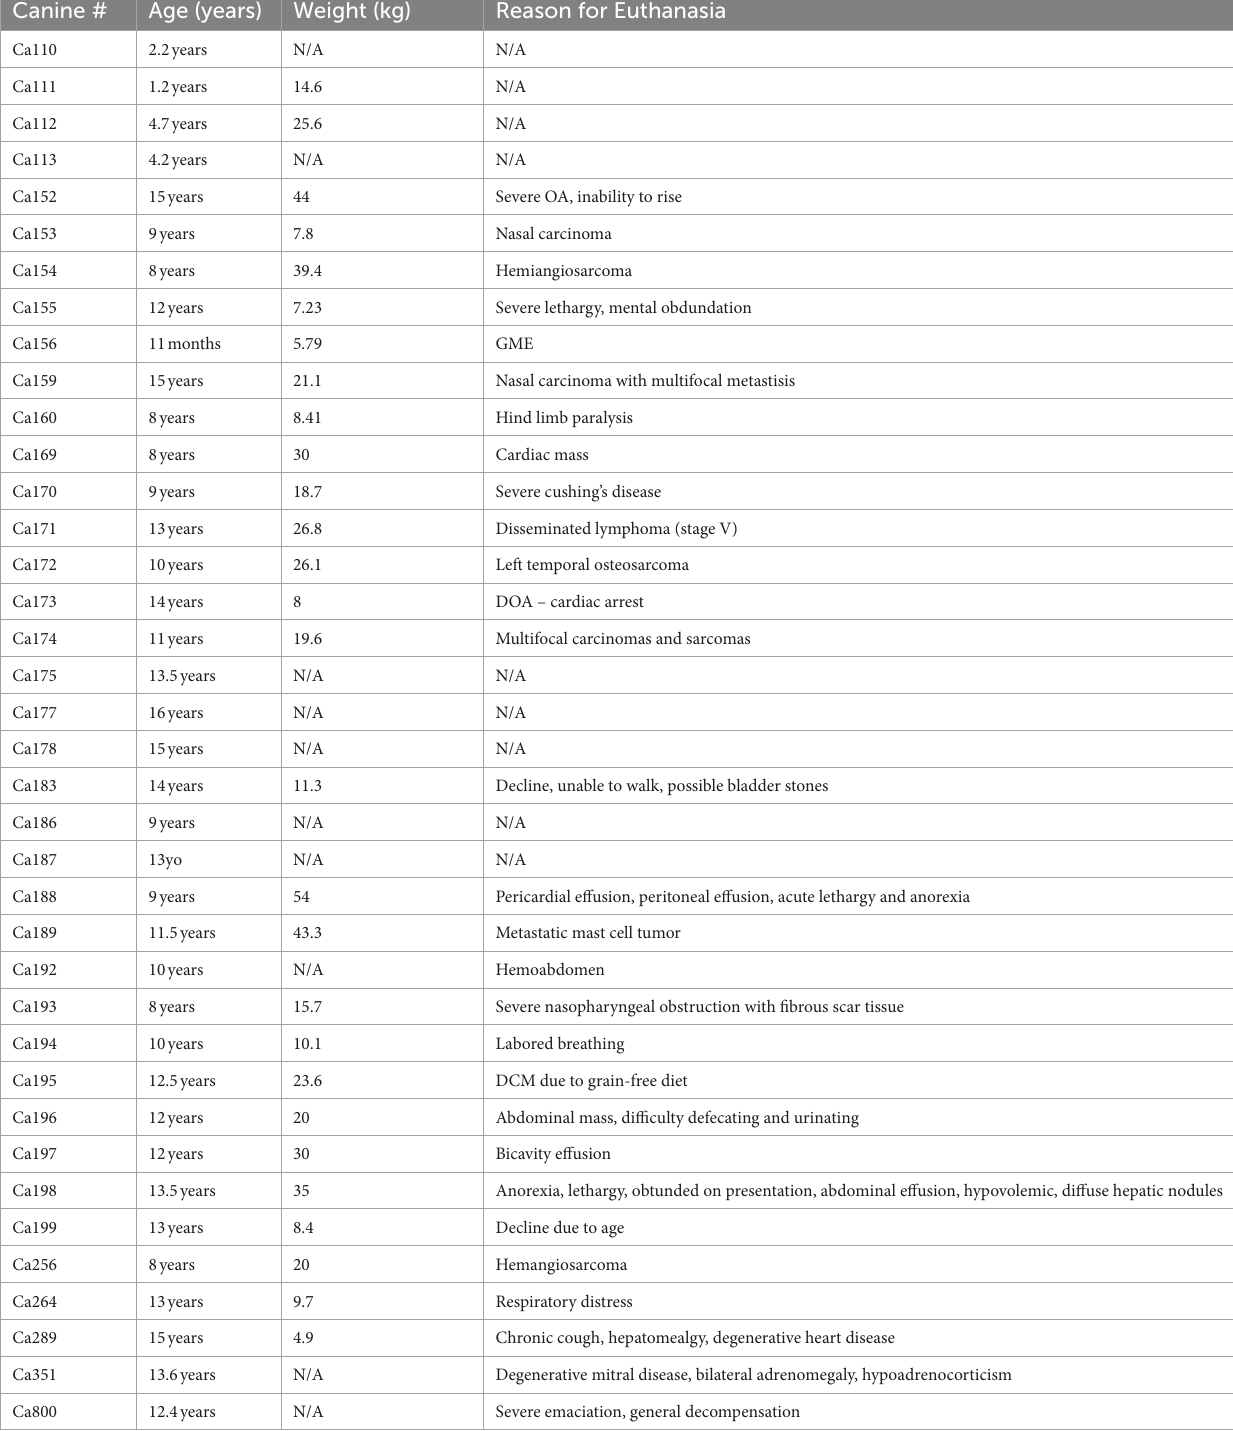
TABLE 1 Aged canine cause of death, age and weight information. Canine